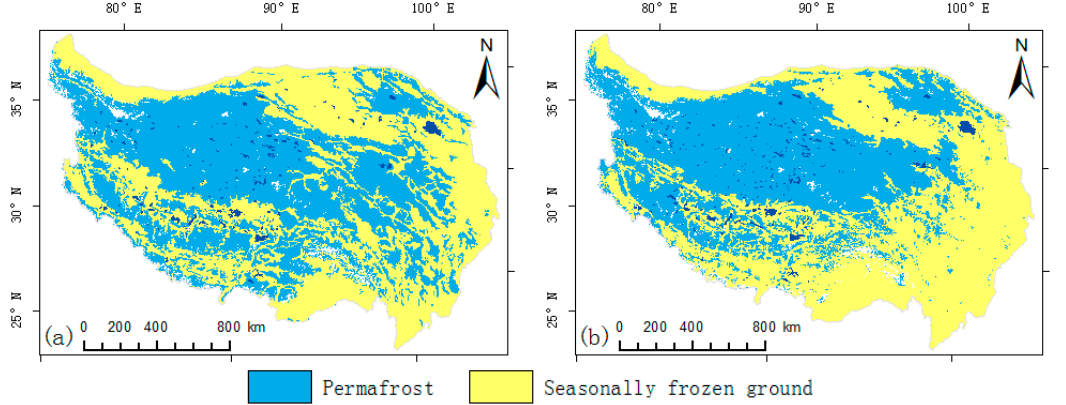
Figure 3. Two permafrost maps: ( a ) 1:3,000,000 Map of Permafrost on the QTP Frozen soil; ( b ) the permafrost map of the QTP derived from 1:4,000,000 Map of the Glaciers, Frozen Ground and Deserts in China.